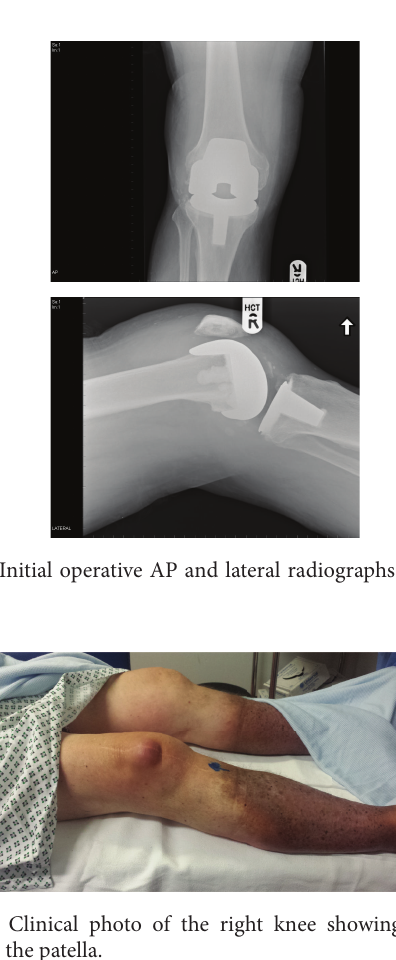
Figure 4: Intraoperative photo demonstrating the patellar button superficial to the